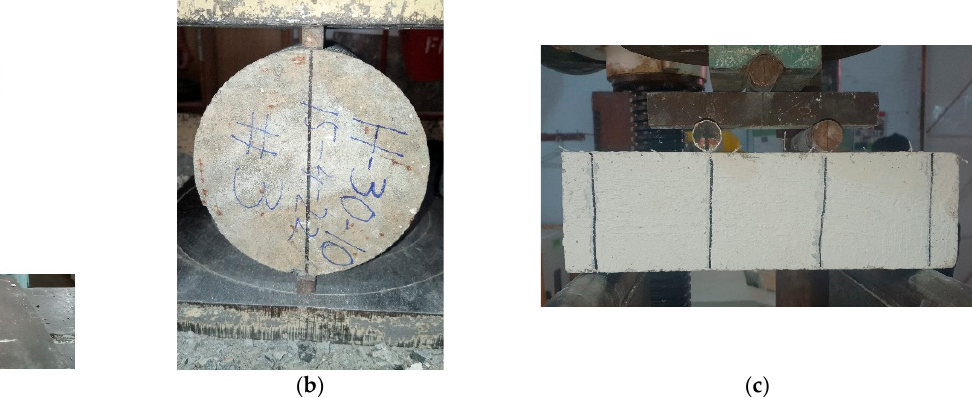
Figure 5. Setups for various tests: ( a ) compressive strength, ( b ) splitting tensile strength, ( c ) flexural strength.